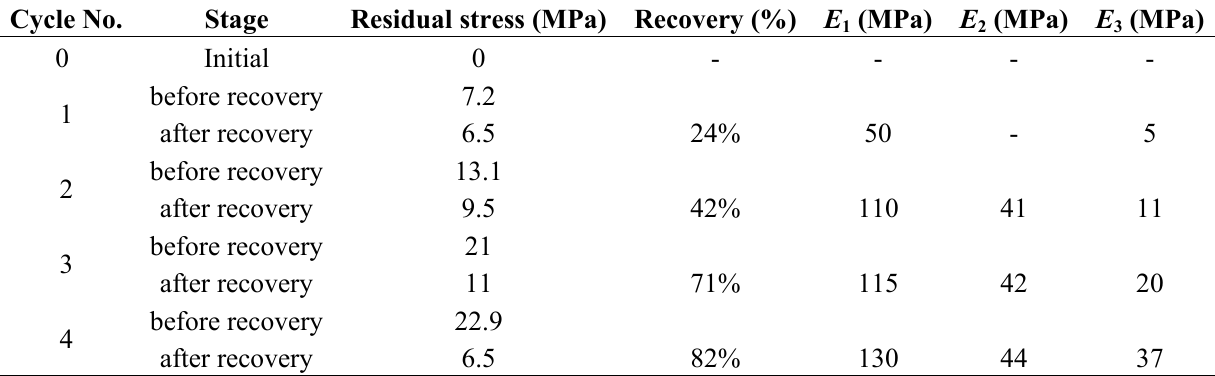
Table 3. Relationship between percentage of recovery and modulus related to the different stages of different cycles of multi-cycle